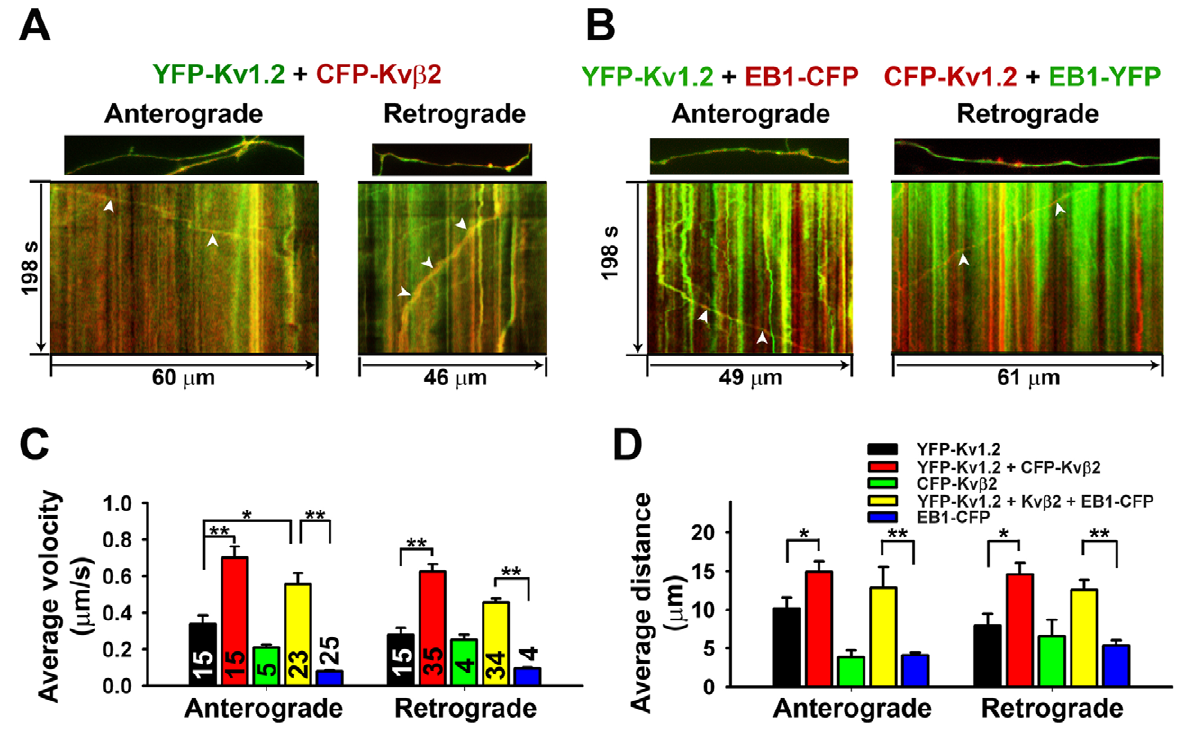
Figure 3. Kv1.2 co-moves with Kv b 2 and EB1 along axons. Hippocampal neurons were transfected at 5 DIV and imaged 2–3 days later. (A) YFP-Kv1.2 (green) co-moved with CFP-Kv b 2 (red) in both anterograde and retrograde directions. The first frame (top) and kymograph (bottom) are provided. (B) YFP-Kv1.2 co-moved with EB1-CFP in the anterograde direction (left). CFP-Kv1.2 and EB1-YFP co-moved in the retrograde direction (right). White arrowheads, co-movements in kymographs. (C) Average travel velocity for puncta containing YFP-Kv1.2 alone (black), both YFP-Kv1.2 and CFP-Kv b 2 (red), CFP-Kv b 2 alone (green), both YFP-Kv1.2 and EB1-CFP in the presence of Kv b 2 (yellow), or EB1-YFP alone (blue). (D) Average travel distance. The numbers within the bars, n, are the same for (C) and (D). *, p , 0.05; **, p , 0.001 in t